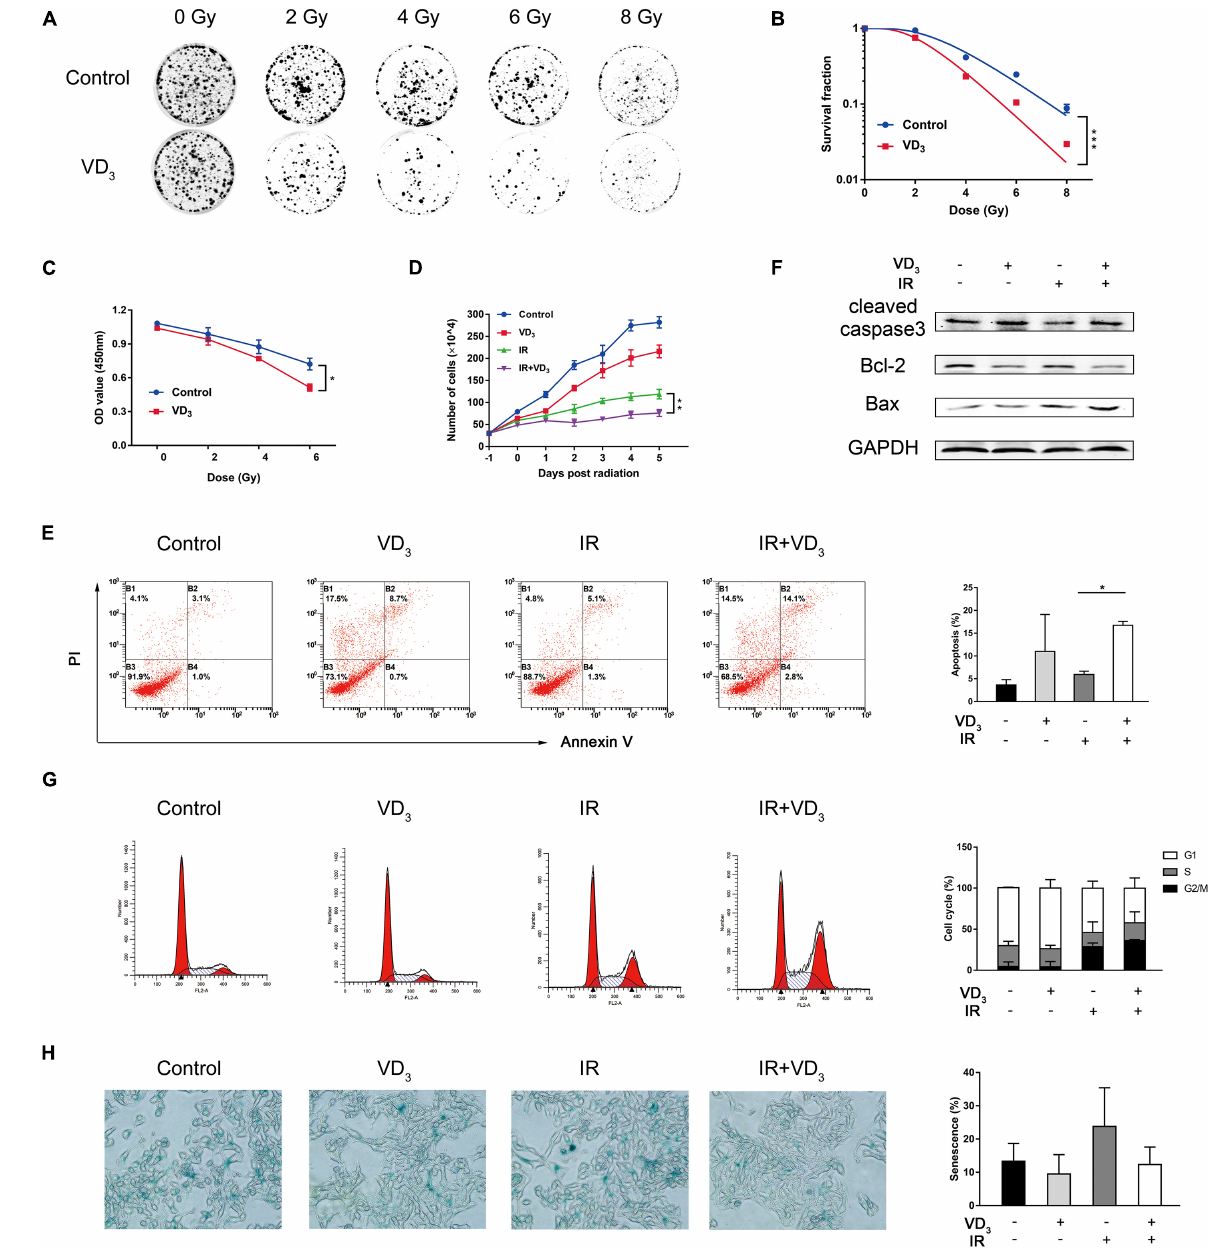
FIGURE 1 | VD 3 enhanced radiosensitivity of CRC cells in vitro. (A,B) Clonogenic assays were used to determine the radiosensitization effects of VD 3 on SW480 cells. Cells were pretreated with VD 3 (100 nM) and subsequently with the indicated IR doses (0, 2, 4, 6, and 8 Gy). Number of colonies was calculated after 2 weeks. (C) Cell proliferation evaluated by the CCK8 assay showed that IR plus VD 3 suppressed cell growth in a IR dose-dependent manner. (D) Combination treatment suppressed cell growth in a time-dependent manner. Cell numbers were recorded every day. (E) Apoptosis analysis of VD 3 or IR treated SW480 cells. Cells were pretreated with VD 3 (100 nM), or IR (6 Gy) and then analyzed by Annexin V/PI. (F) Expression of apoptosis proteins were assessed by western blot. (G) Cell cycle analysis of